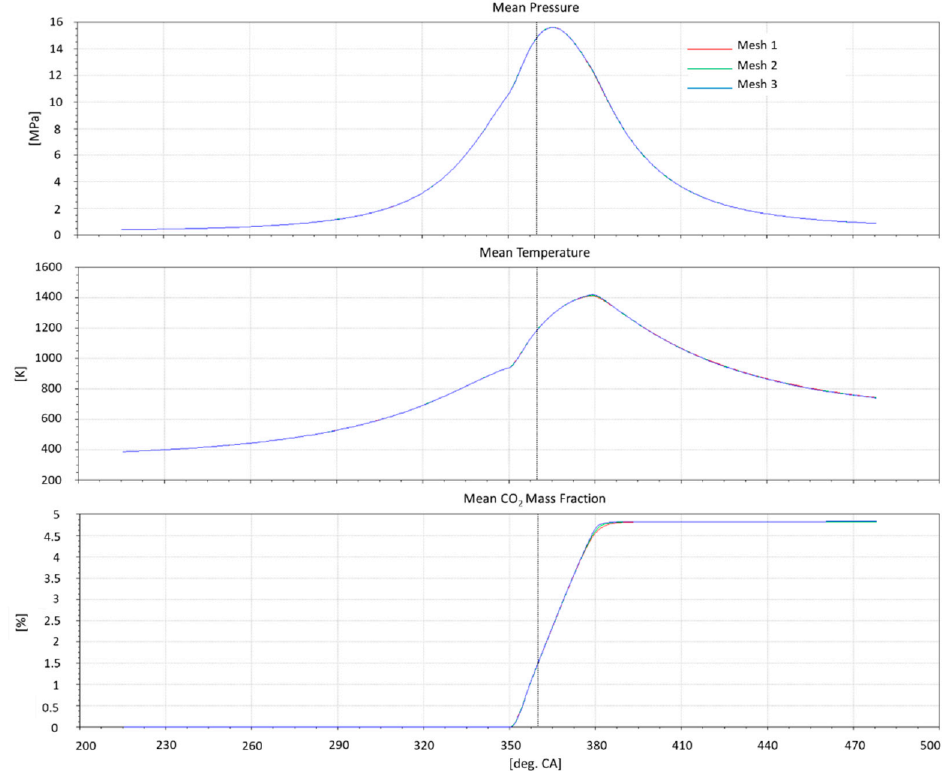
Figure 6. The CFD results of the simulations using the three different mesh